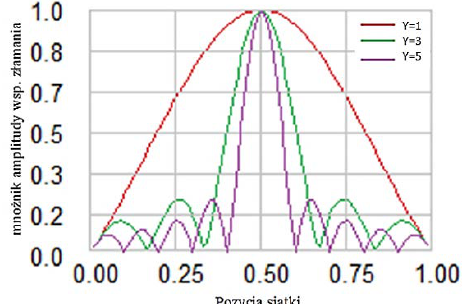
Fig. 17. Sine apodization function for different values of the parameter Y at constant value X=1.